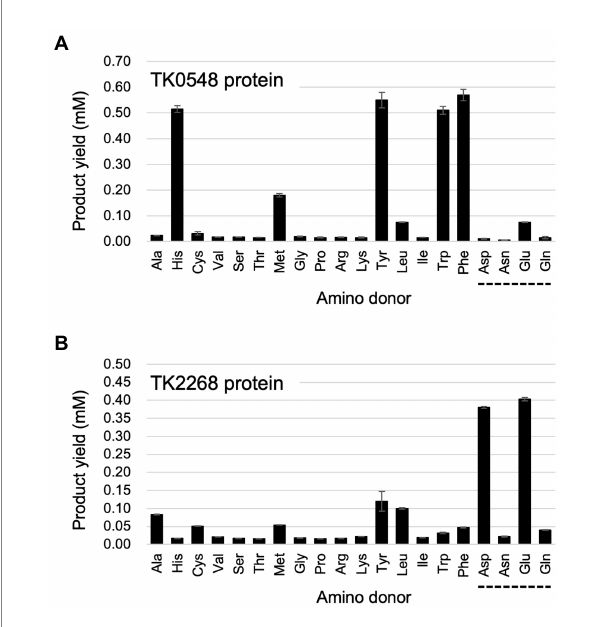
FIGURE 3 Examination of the amino donors recognized by the recombinant TK0548 (A) and TK2268 (B) proteins. Each protein was incubated for 15 min at 80 ° C with the indicated amino acids and 2-oxoglutarate